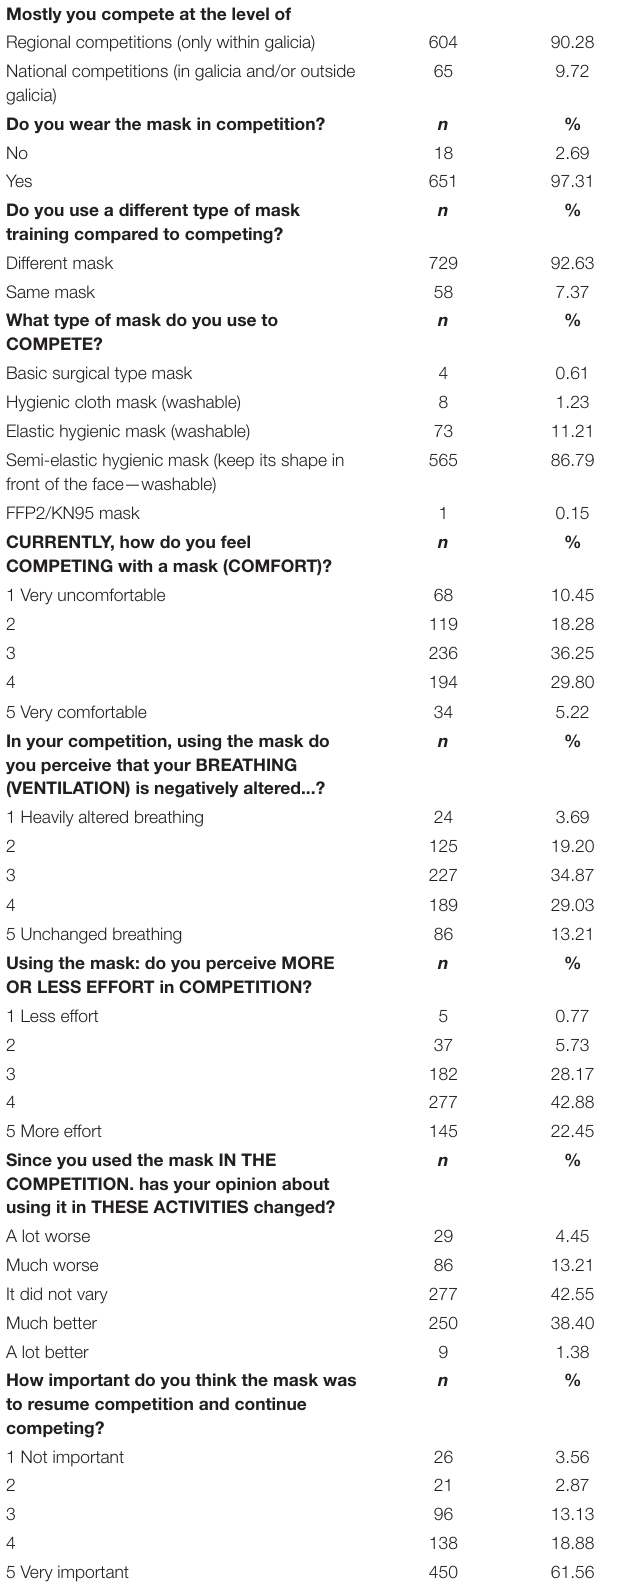
men. Considering the perception of the use of the mask in training, with respect to the perceived global effort, χ 2 (4, N was more, or something more than effort compared to 58.62% 65 9.72 of